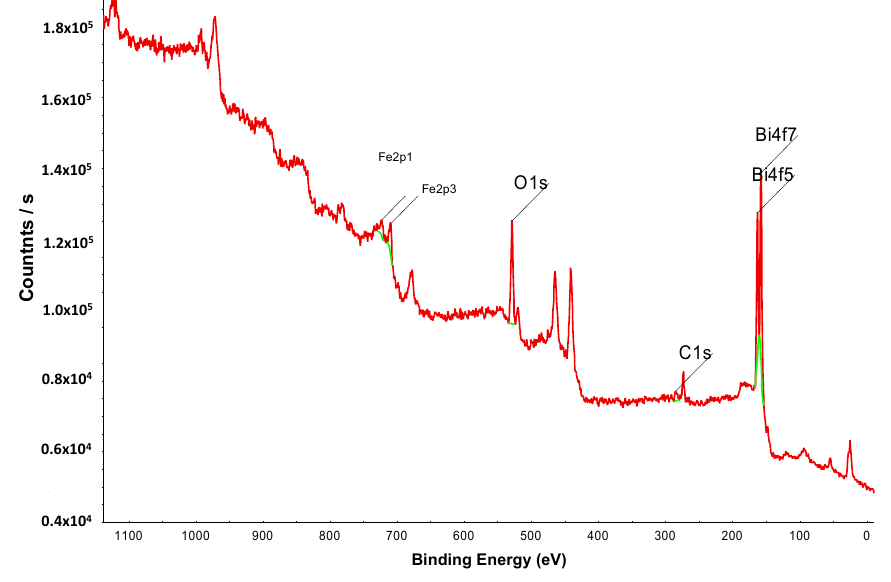
Figure 3. The entire XPS spectrum of BF.